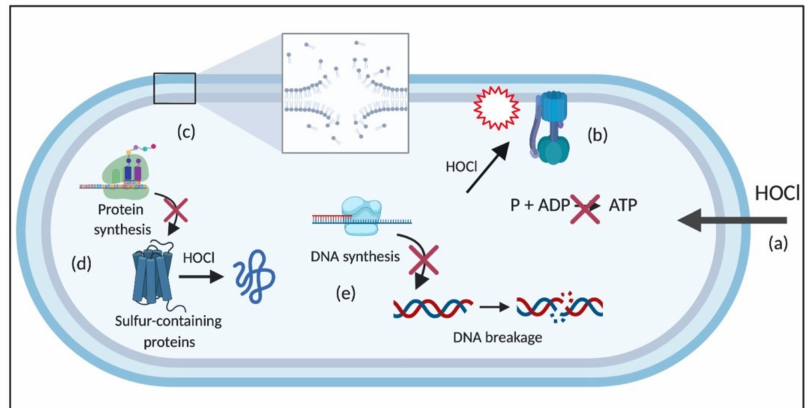
Figure 2. Schematic of HOCl targets in Gram-negative bacterial cells. ( a ) HOCl easily penetrates the bacterial cell due to its neutrality and attacks ( b ) several membrane components and processes, including transporters and proteins, such as ATPase, which disrupts ATP production ( c ) lipids, causing, forexample, lossofmembranestability, ( d )proteinsynthesisandproteins, especiallythesulfur-containing ones, and ( e ) DNA, leading to DNA breakage and impairment of DNA synthesis. HOCl: hypochlorous acid; P: phosphate; ADP: adenosine diphosphate; ATP: adenosine